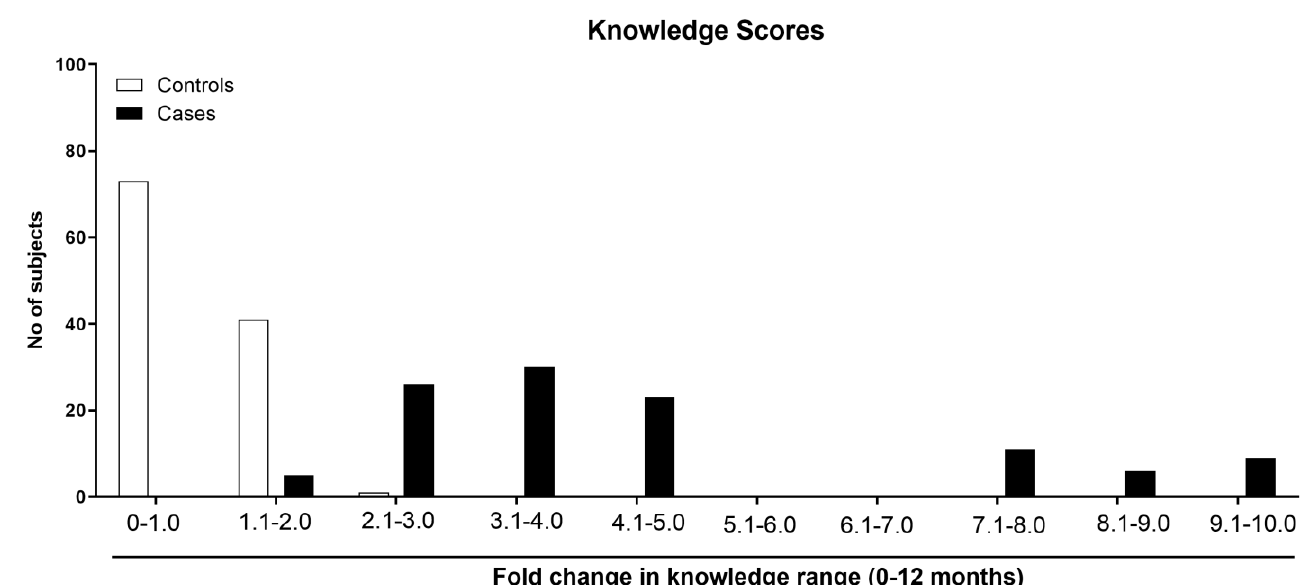
Figure 5. Phone call-based education improved participants’ knowledge about diabetes. In addition to reducing the HbA1C, providing phone call-based education enhanced participants’ knowledge, as evidenced by the presence of a greater number of study participants in the higher knowledge score groups. Participants in the control group who had not received any phone call-based education remained in the lower knowledge score category, indicating that the phone call-based education improved the knowledge of the participants and thereby helped them to mitigate the complications of diabetes.